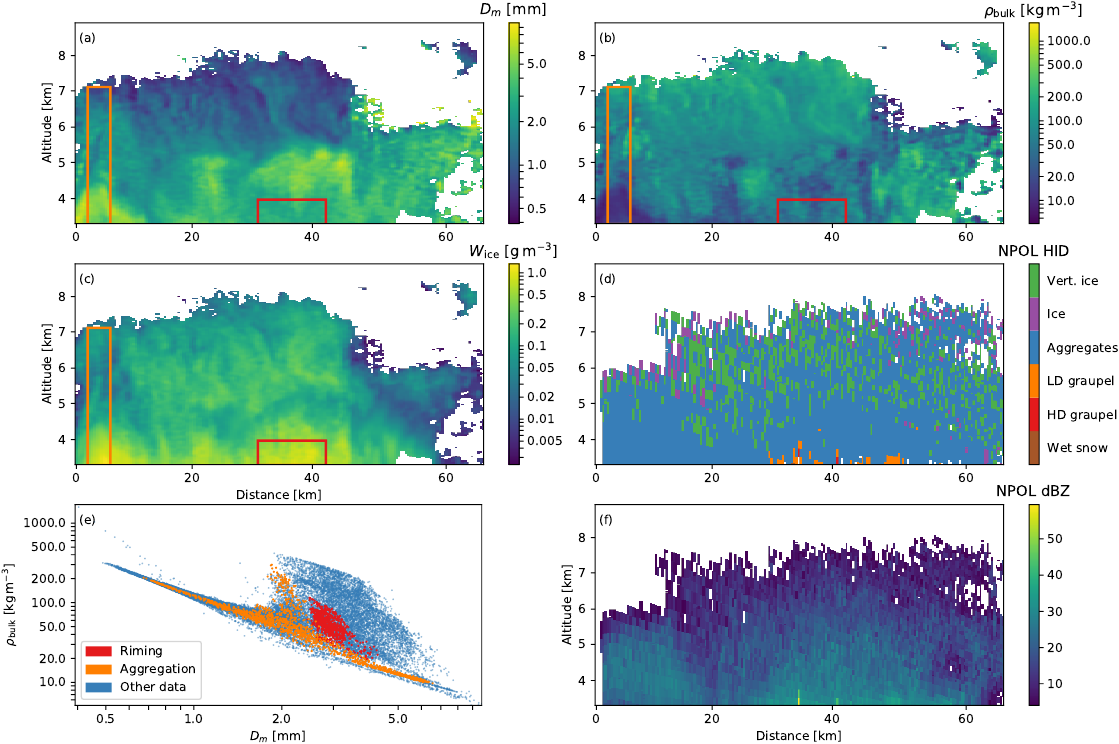
Figure 2. Data from the 3 December 2015 case described in Sect. 5.1. (a) The mass-weighted mean diameter D m (Eq. 14). (b) The bulk density ρ bulk (Eq. 16). (c) The ice water content (Eq. 12). (d) The NPOL hydrometeor identification. (e) A scatter plot of D m and ρ bulk from (a) and (b) , with the red and orange points identifying the data inside the boxes of corresponding colors shown in those panels. (f) The radar reflectivity observed by